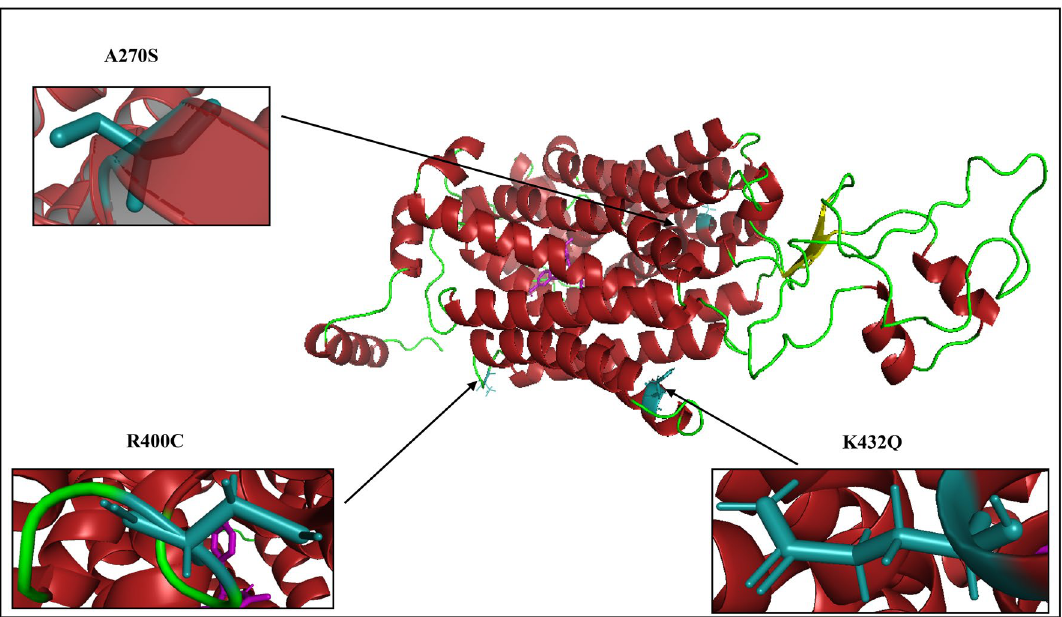
Figure 3. 3D structure of SLC22A2 in complex with 5RE generated by AlphaFold 2: the three mutated residues identified in the South African Xhosa population are shown as sticks (coloured deep-teal) and the 5RE inhibitor in magenta. Solid black arrows point to the locations of the mutations identified to characterise the haplotypes existing in the study